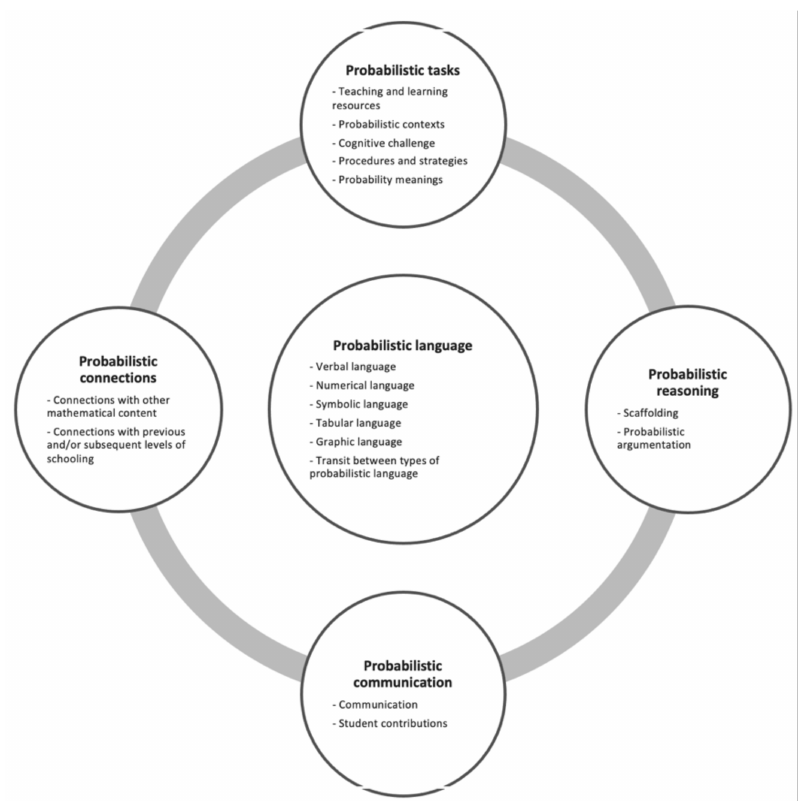
Figure 2. Aspects and components that characterise a model for effectively teaching probability from an early age (Adapted from [9] (p.7)). (Reprinted with permission from ref. [9]. Copyright 2019,